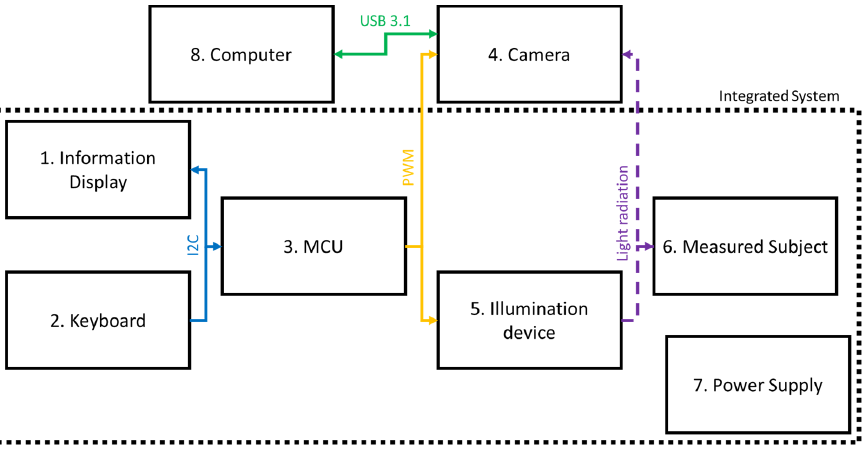
Figure 1. Block diagram of the proposed system.